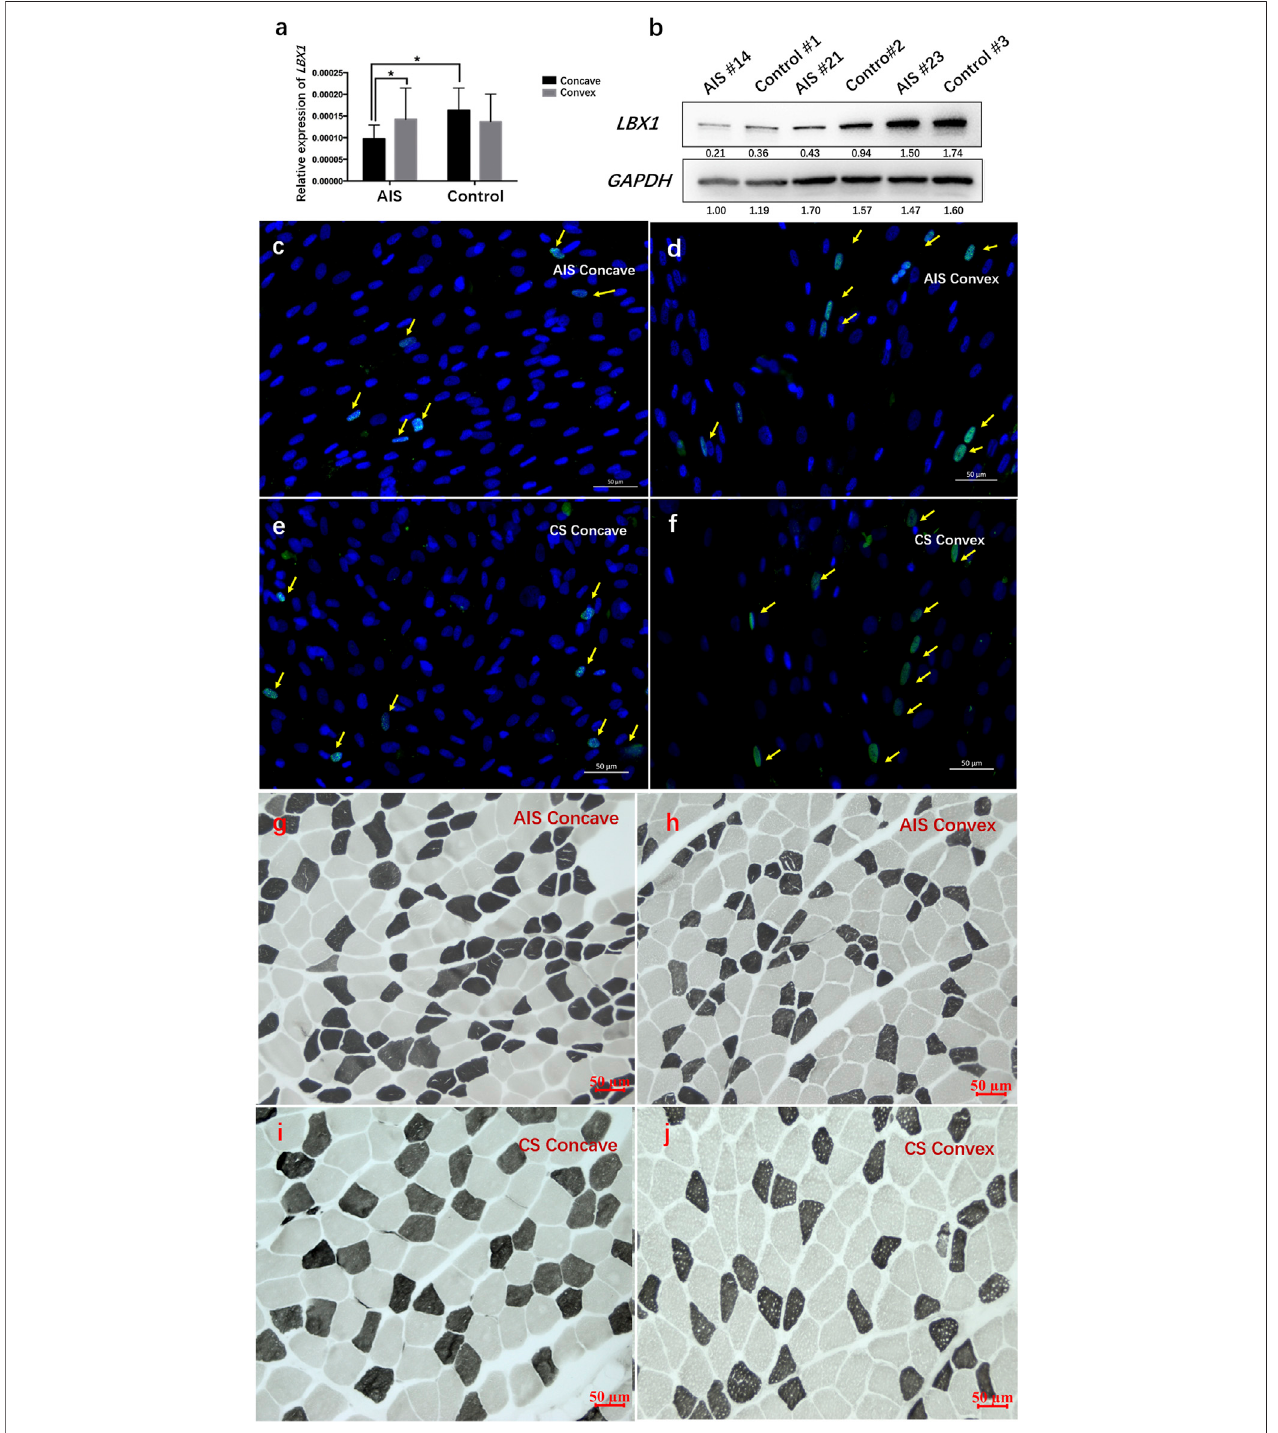
FIGURE 2 | AIS patients had globally down-regulated LBX1 expression as well as smaller muscle fi ber in the bilateral sides of paraspinal muscles. (A) The mRNA expression of LBX1 was remarkably deceased in the bilateral side of AIS as compared with that in the bilateral sides of CS patients. (B) The protein expression of LBX1 was remarkably lower in the paraspinal muscles of AIS than CS. (C – F) Target protein was stained in green (arrows). DAPI was stained in blue. Remarkably lesser expression of LBX1 was found in the paraspinal muscles of AIS as compared with CS. (G – J) ATPase staining following preincubation at pH 9.4 showed the lightly stained type I fi bers and the darkly stained type II fi bers. Globally smaller type I fi ber in the paraspinal muscles of AIS can be observed as compared with CS patients.